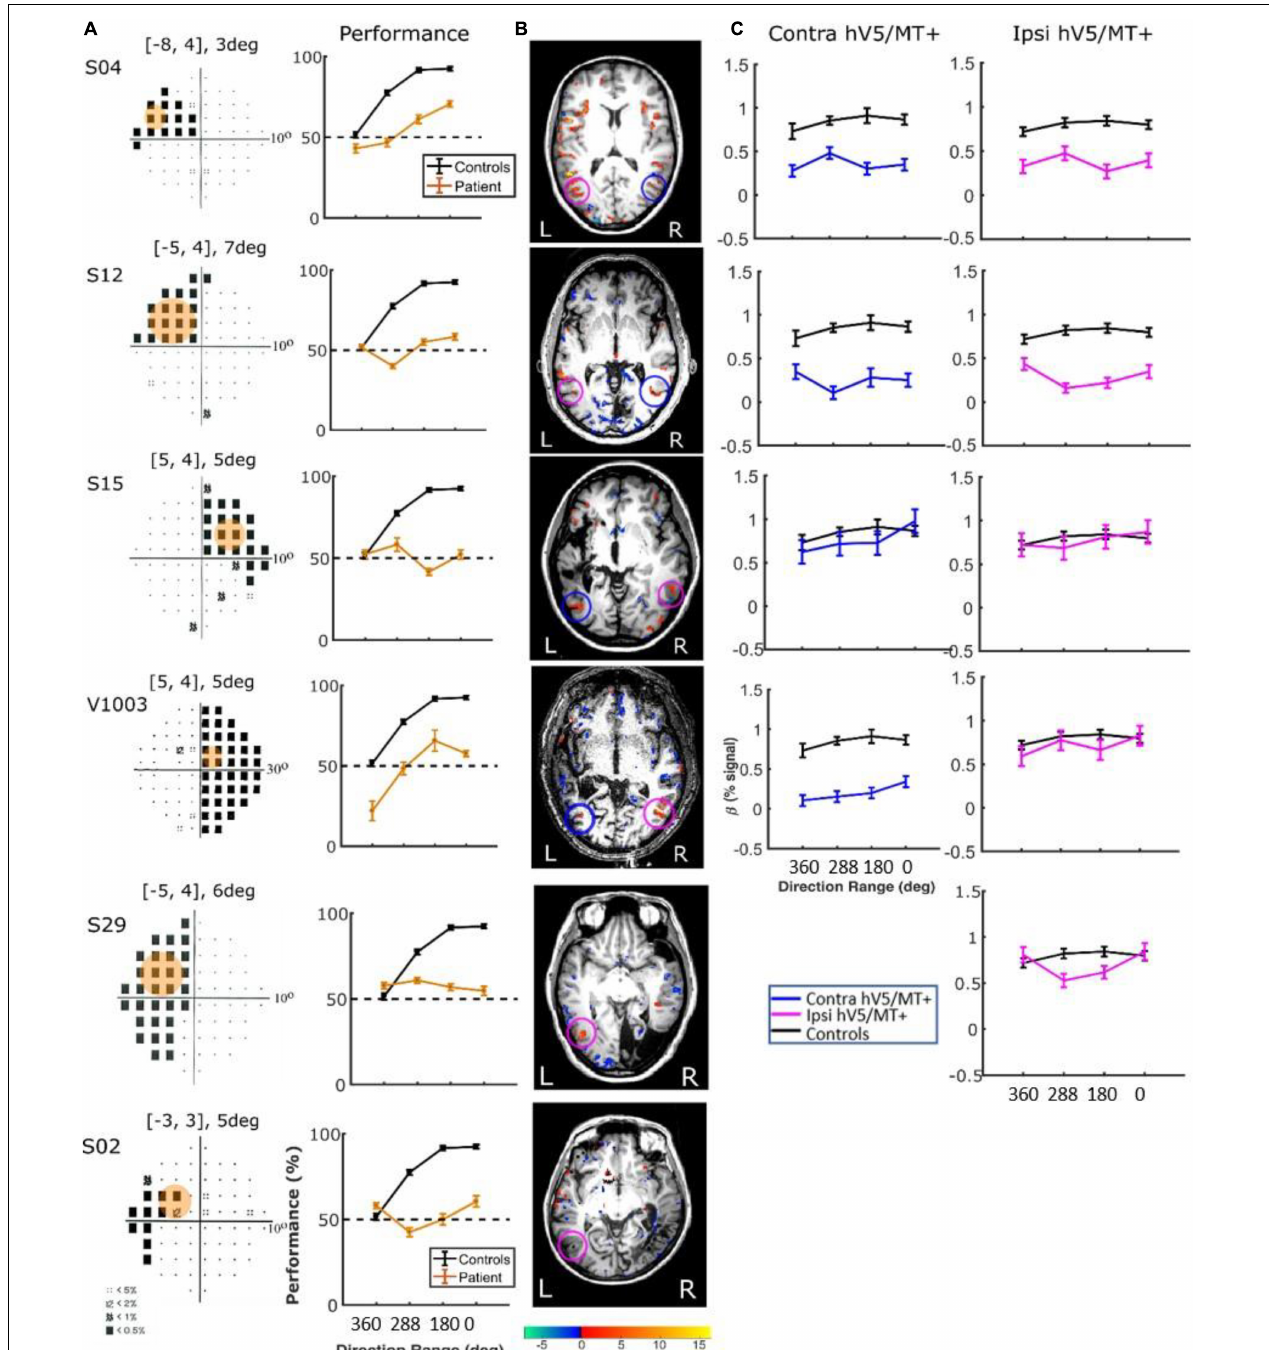
FIGURE 10 | Behavioral performance and hV5/MT+ responses to motion coherence within the blind field of patients performing a motion direction discrimination task. (A) Left column: Visual field deficits for each patient based on perimetry and location of the stimulus aperture (orange disk). The center coordinates and diameter of the aperture are shown on top of each graph in the form [ x , y ], z deg, where x = deg from vertical meridian, y = deg from horizontal meridian, and z = deg diameter. Right column: Behavioral performance for the motion direction discrimination task when the stimulus was presented within the blind field of patients (orange) versus control subjects (black). (B) Activation maps when the stimulus was presented within the blind visual field. We found significant activity for both the contralesional (blue circle) and ipsilesional (magenta circle) hV5/MT+. (C) Mean GLM β weights of contralateral (blue) and ipsilateral (magenta) hV5/MT+ across patients as a function of coherence level compared with control subjects (black). The variability observed could relate to differences in the type of lesion that each subject has or differences in the ability of the subjects to cope with the requirements of the active task. The fact that some subjects show responses at the level of sighted controls is consistent with the hypothesis that responses are driven by task-related load or